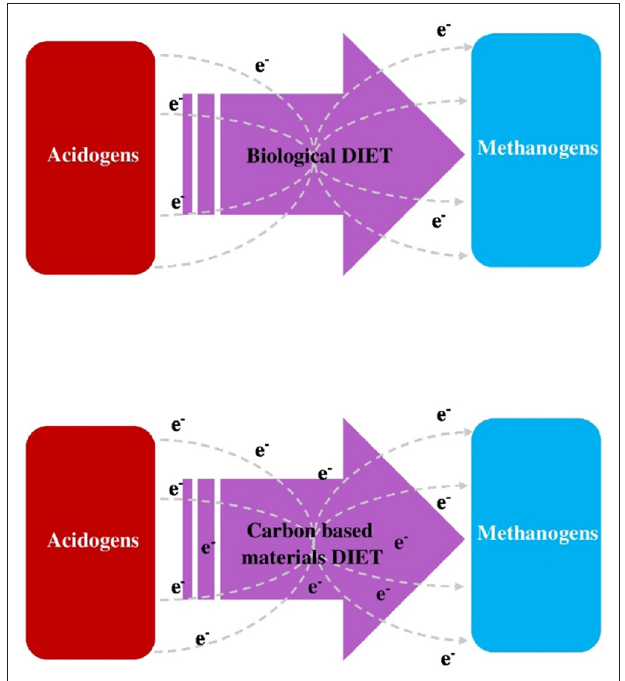
TABLE 2 | Function of carbon-based materials as additive in anaerobic digestion.